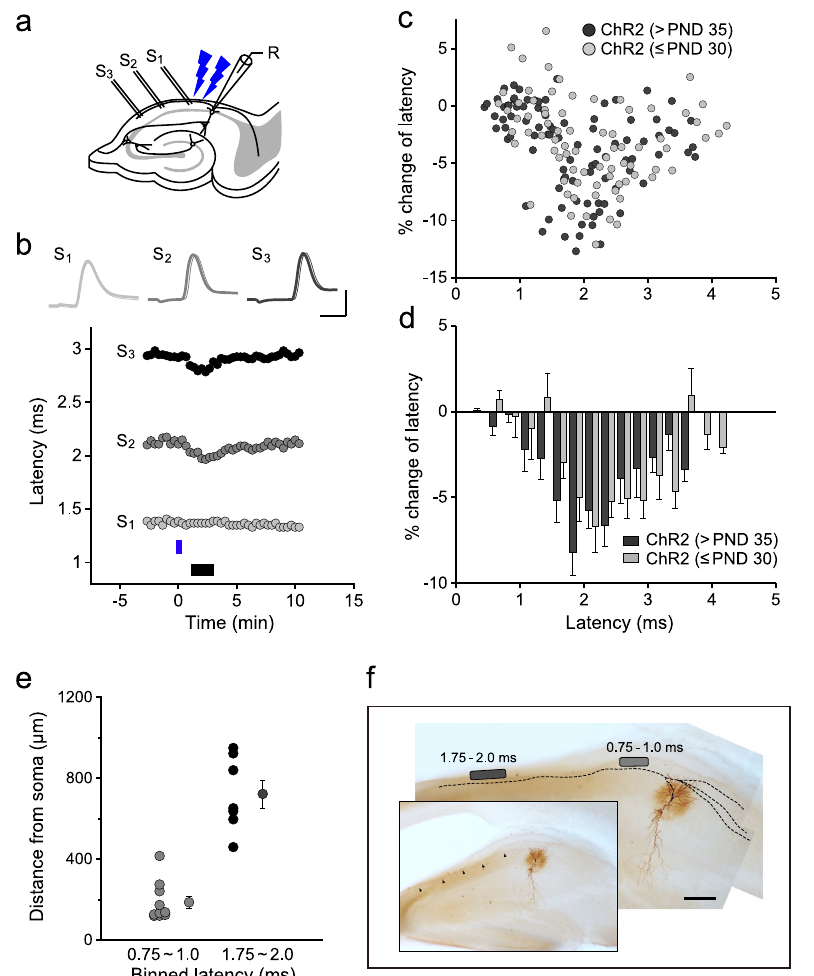
action potentials with different stimulating positions (S 1 – S 3 ) in a CA1 pyramidal cell. b Time course of the latency of action potentials evoked at